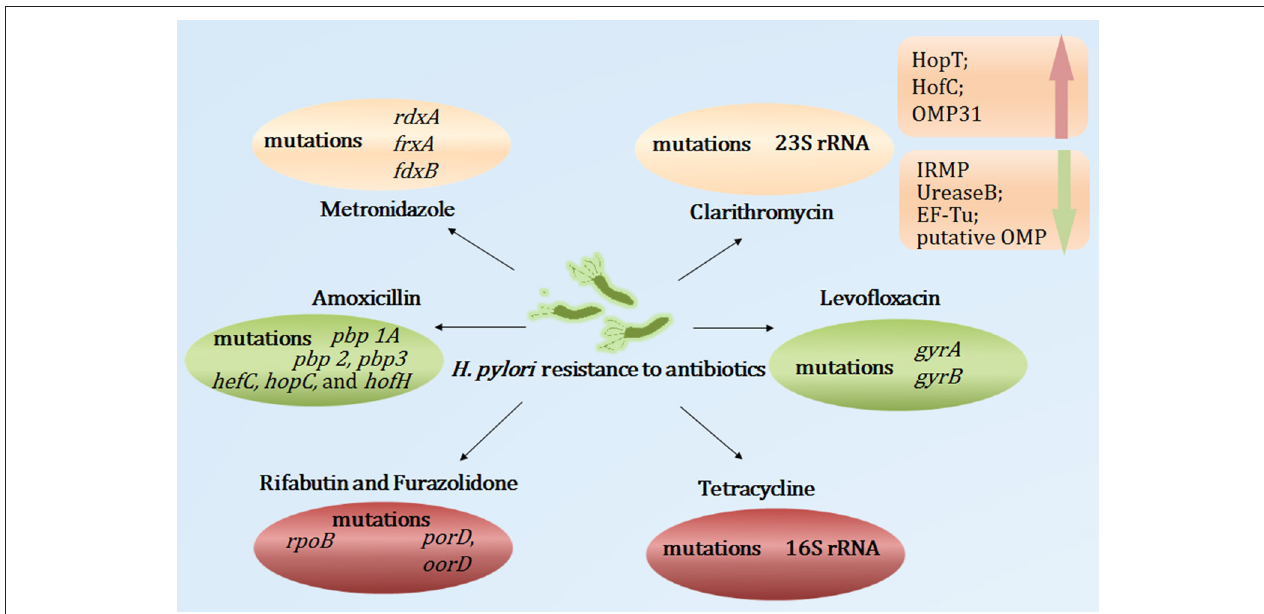
FIGURE 2 | Summary of mutations and novel mechanisms involved in H. pylori antibiotic resistance. OMP, outer membrane protein; IRMP, iron-regulated membrane protein; EF-Tu, elongation factor thermo